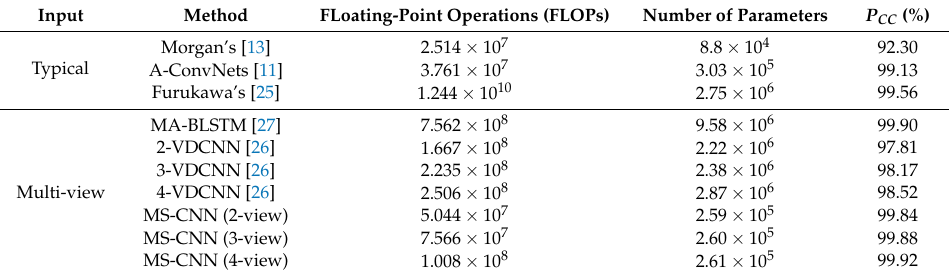
Table 5. Comparison of the number of parameters.